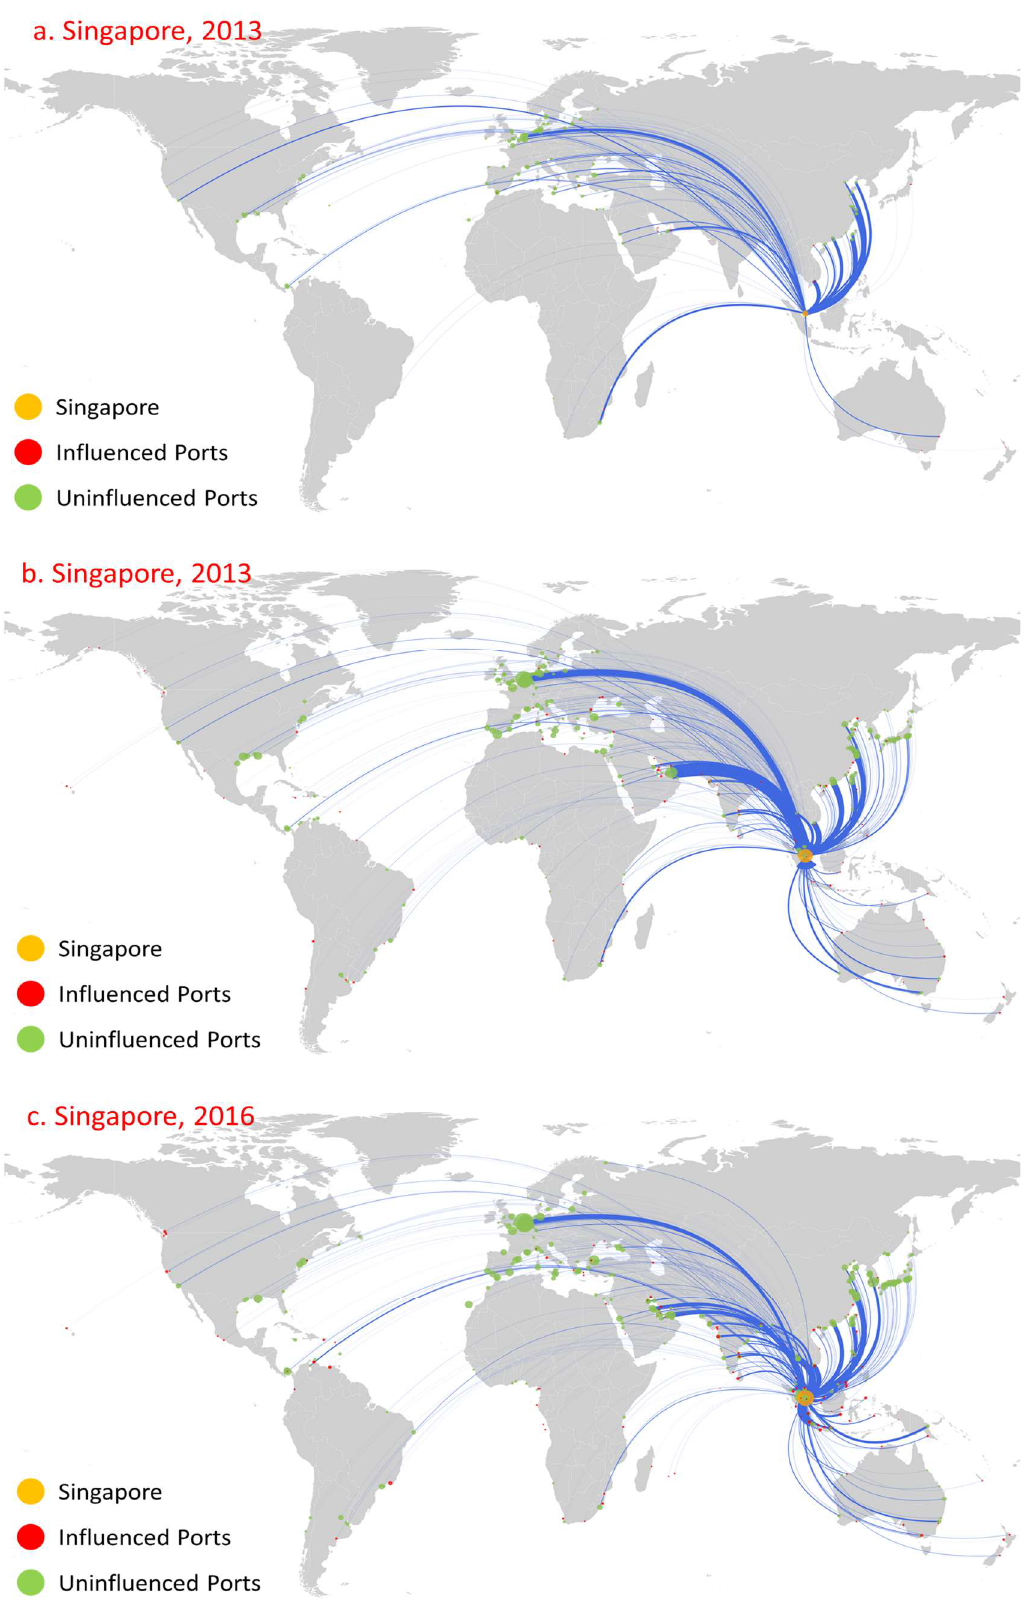
Figure 6. Influence diffusion at the first stage: Singapore.